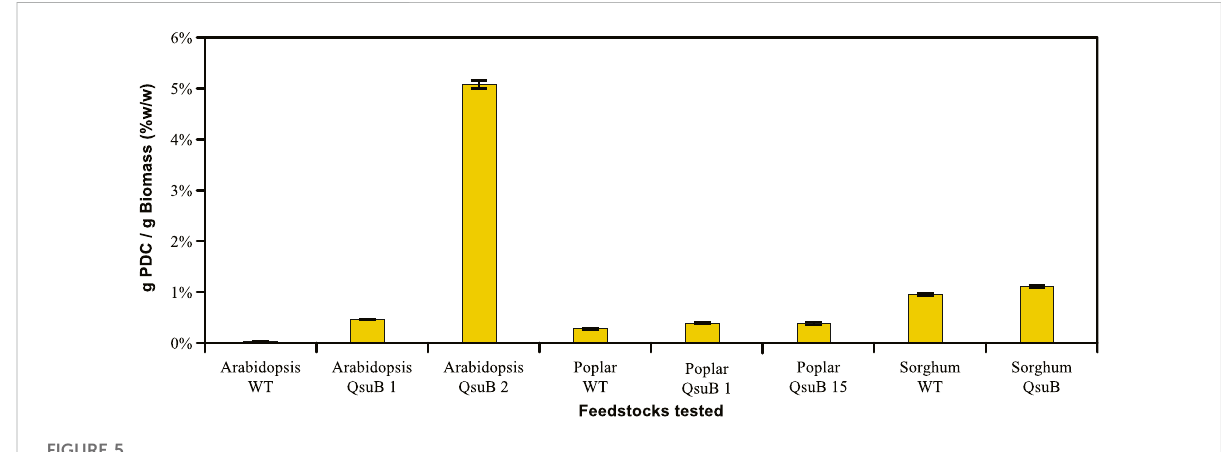
FIGURE 5 Comparison of 2-pyrone-4,6-dicarboxylic acid (PDC) yields among wild-type and QsuB lines of Arabidopsis, poplar, and sorghum, normalized per dry weight of biomass